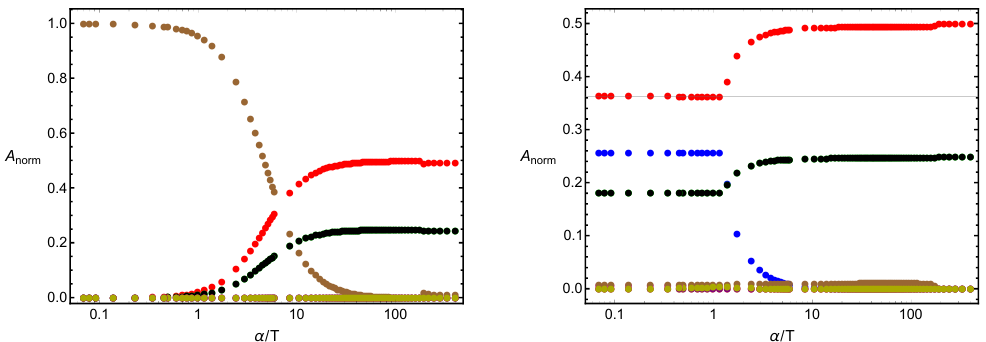
Figure 6 . The amplitudes of the various operators (4.7) for the thermo-electric diffusive modes in the normal phase with momentum dissipation. We fixed k/T = 0 . 01 and T/µ = 0 . 025 . The color scheme is that illustrated in